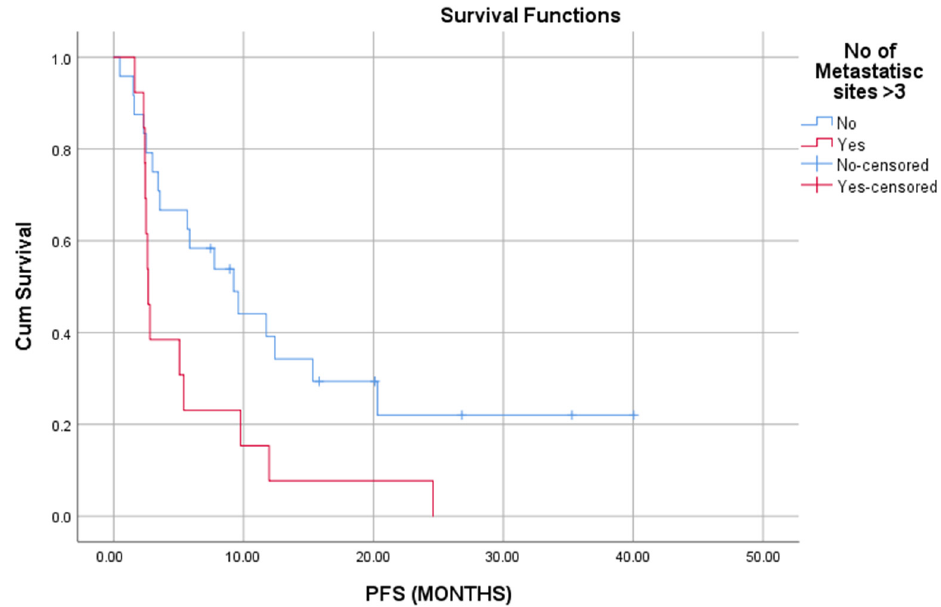
Figure 2. Responders to ICI have better progression free survival as compared to that of nonre- sponders ( p < 0.01).